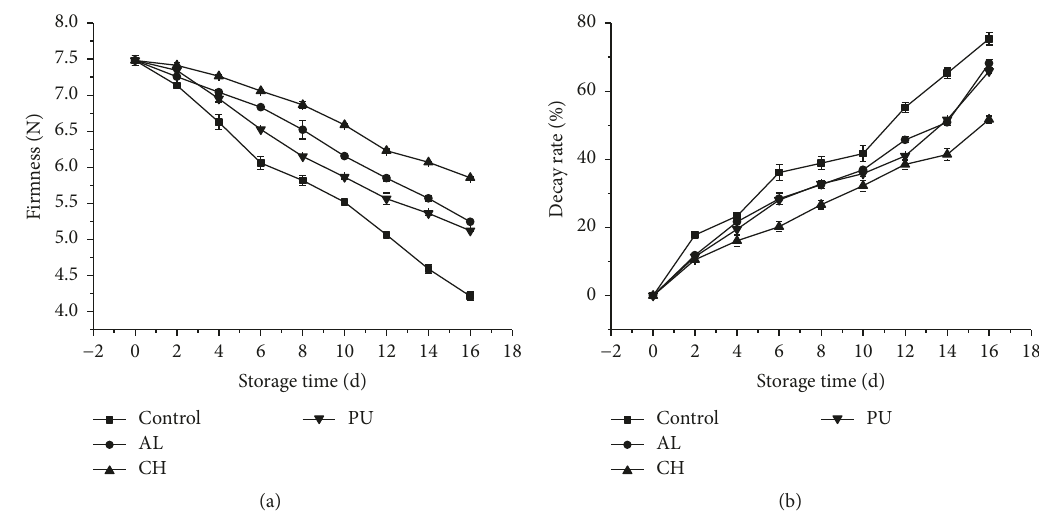
Figure 1: Effects of three different polysaccharide-based edible coatings on firmness (a) and decay rate (b) of strawberry.